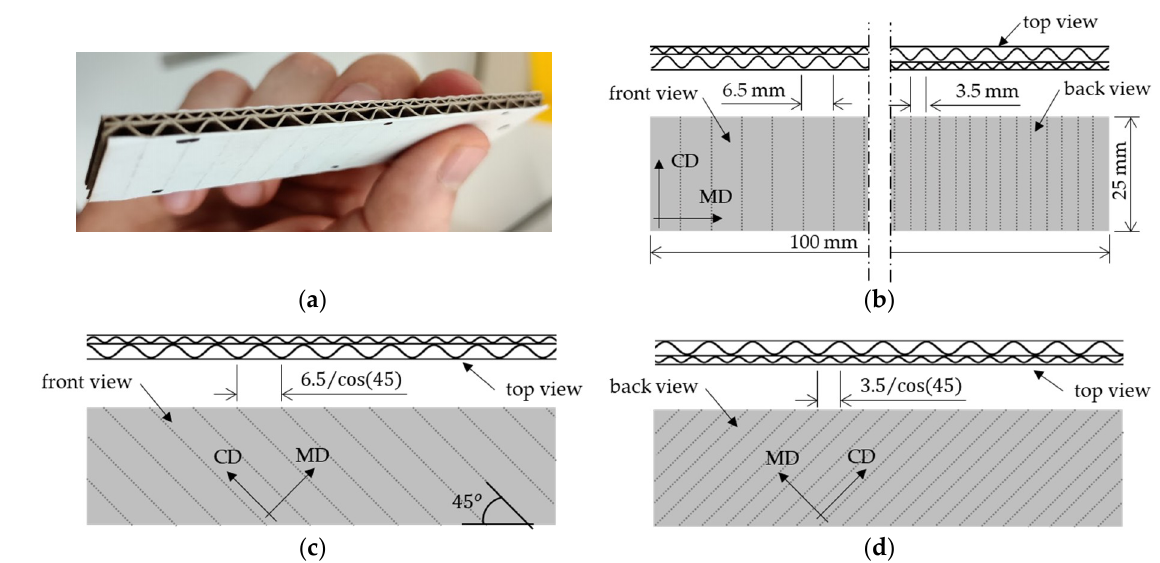
Figure 3. The sample for the standard and new edge crush test: ( a ) standard sample view; ( b ) standard ECT sample–front, back and top view; ( c ) new ECT sample–front and top view; ( d ) new ECT sample–back and top view.